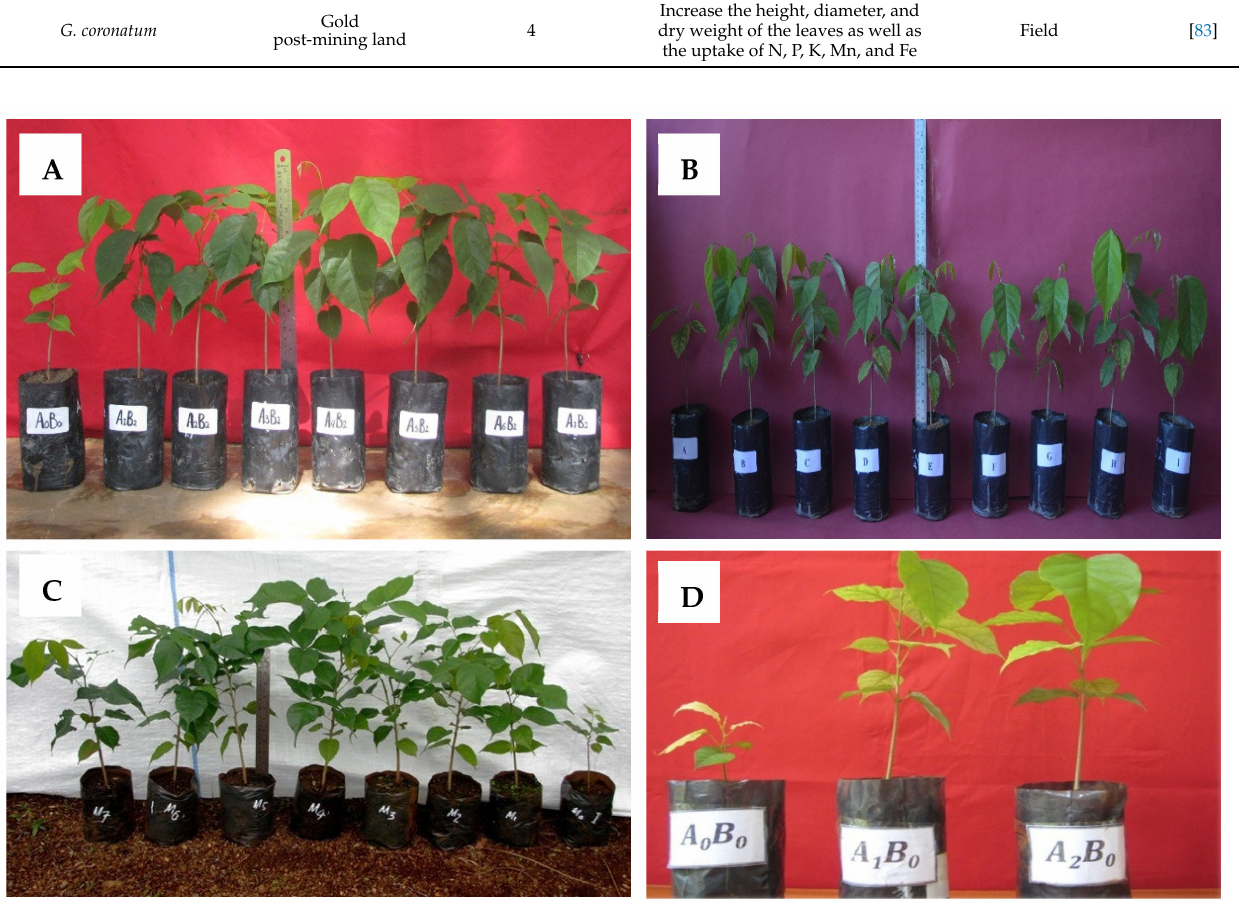
Figure 4. Visualization of growth performance of mycorrhizal and non-mycorrhizal P. mooniana at greenhouse and nursery scales. ( A ) Coal overburden (OB) media [90], ( B ) gold tailings media [83], ( C ) serpentine soil media/post-nickel mining [87], and ( D ) serpentine soil media